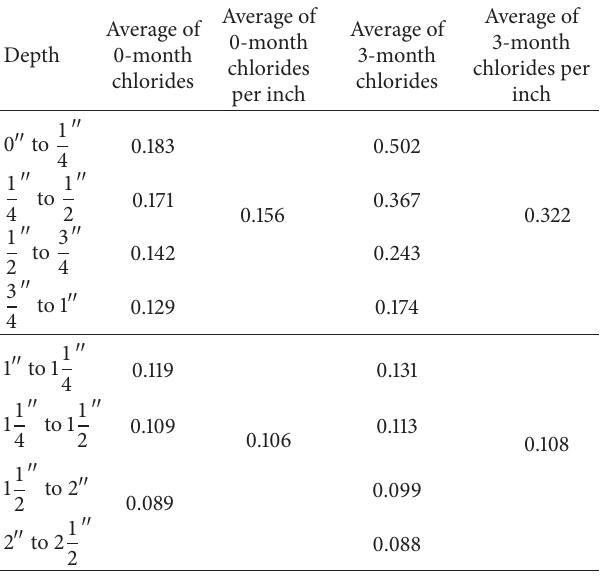
Table 4: Comparison of initial intended and average acid-soluble chloride contents of CoC specimens (% chlorides by concrete weight) at 0 month (1 inch = 25.4 mm).